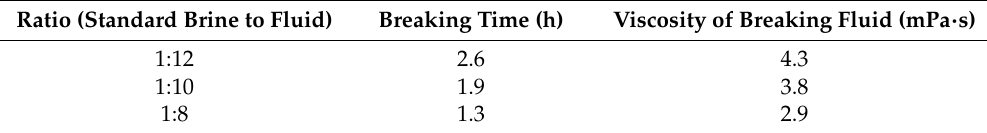
Table 2. 5 wt % VES fluid gel breaking at different brine ratios. Ratio (Standard Brine to